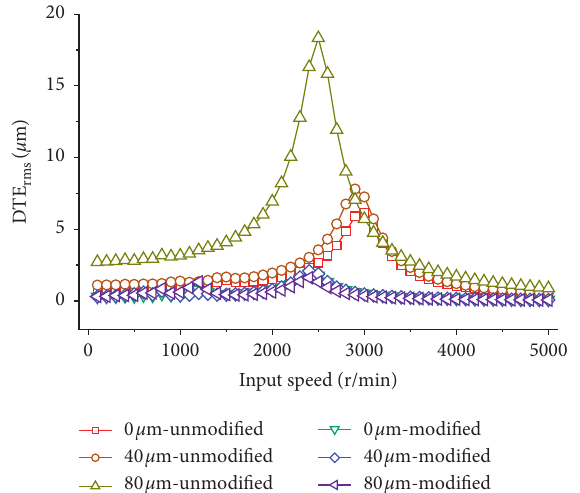
Figure 18: Root mean square values of DTE versus input speeds under different mesh misalignment